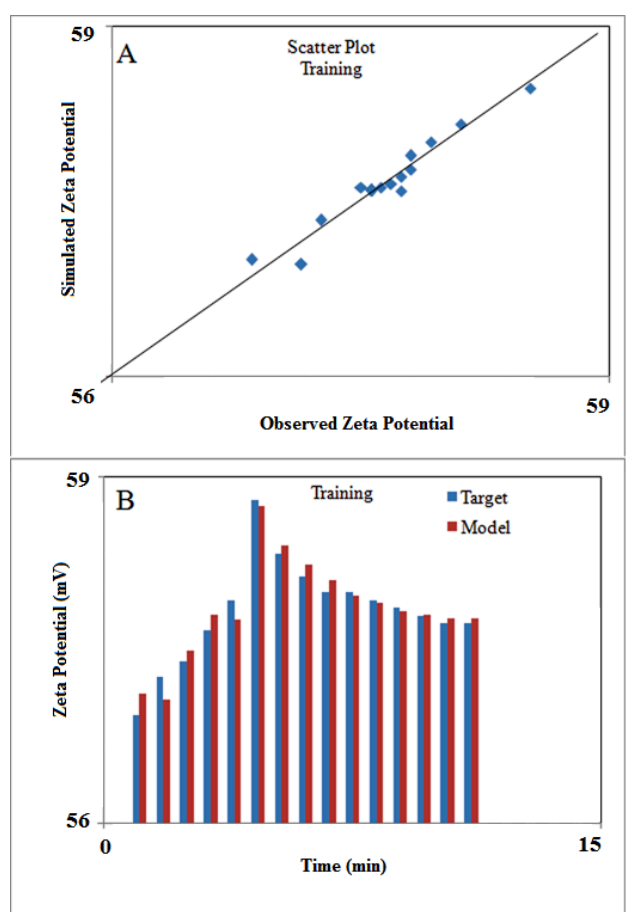
Fig. 5. Output of testing procedure of model.